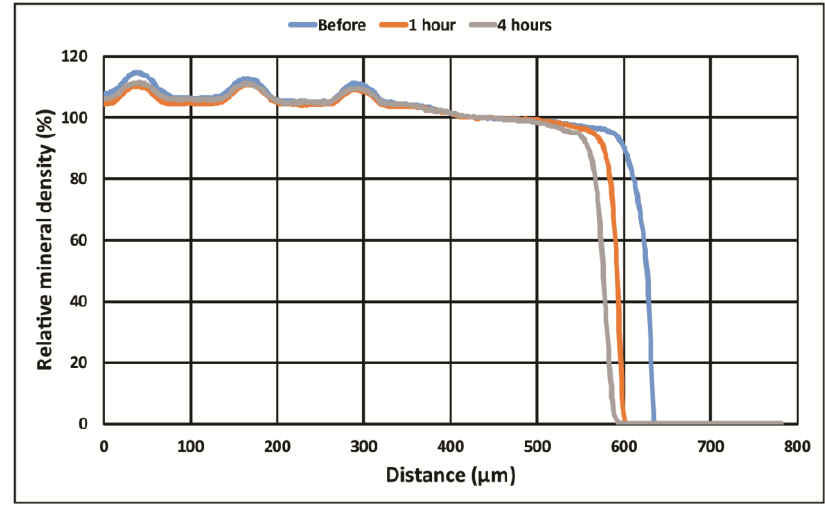
Figure 3. An example of a dentin sample exposed to 0.25% CA/0-F solution showing the aligned dentin profiles from which the surface loss is determined. The blue line is the initial relative mineral density profile at time 0; the orange line is the relative mineral density at 1 h; and the grey line is the relative mineral density at 4 h. The mineral density profiles of the three X-ray images of the dentin are aligned to the X-ray dense TEM grid, which is the three peaks located at 50, 160, and 270 μ m from the left edge of the image. The difference between the blue line (initial profile) and the orange line (1 h) at 20% mineral density is the amount of surface mineral lost. Likewise, the difference between the blue line and the grey line (4 h) at 20% mineral density is the amount of surface mineral lost. The erosive loss for this sample was 35.2 μ m in 1 h and 48.8 μ m in 4 h. Table 1. Dentin surface lost due to erosion ( μ m) for each of the 12 experimental groups at 1 h of erosive exposure. Values are average ± standard deviation, n = 4 for each group. A positive mean value indicates the erosion loss, a negative mean value indicates a mineral gain on the surface. The letters associated with each experimental group (A, B, C, etc.) designate experimental groups that are statistically different at p < 0.05 (groups with the same letter are not statistically different) as determined by two-way ANOVA followed by post hoc ranked comparisons. Experimental groups with combinations of letters are members of each group at p > 0.05.